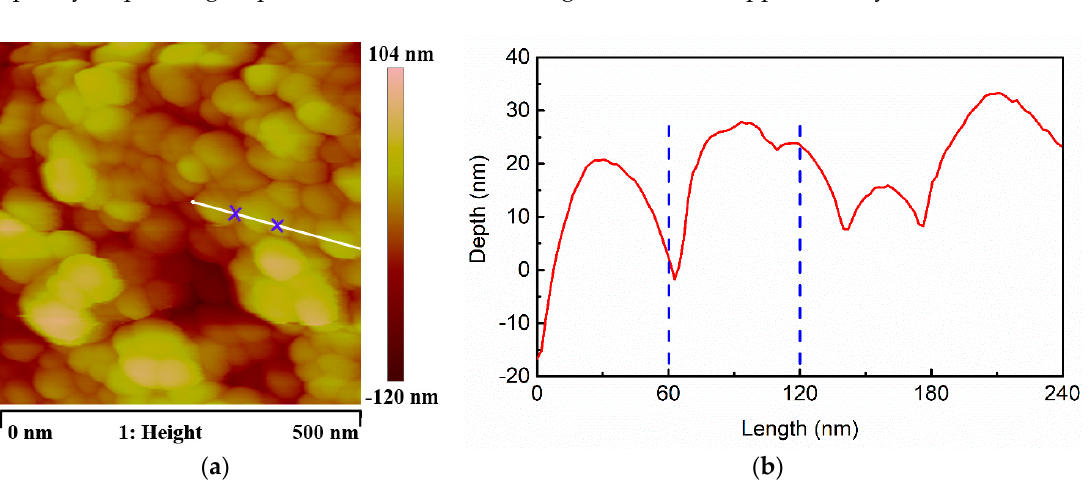
Figure 5. AFM image of TiO 2 based aqueous super-hydrophobic suspension coated on a silicon wafer: ( a ) Top view; ( b ) Sectional height difference along the white line in ( a ).